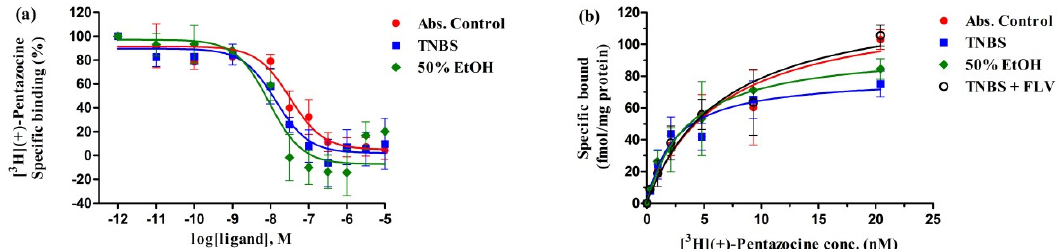
Figure 1. ( a ) Homologous displacement curves for ( + )-pentazocine against [ 3 H]( + )-pentazocine (2.3 nM) binding to sigma-1 receptor ( σ 1R) site in control (Abs. Control) and 2,4,6-trinitrobenzenesulfonic acid-induced colitis (TNBS) or 50% ethanol enema (50% EtOH) treated rat colon membranes. ( b ) Homologous saturation isotherm for [ 3 H]( + )-pentazocine (0.26–20.4 nM) binding to control (Abs. Control) and TNBS-induced colitis rat colon membrane in the absence (TNBS) or presence of 1 mg / kg FLV administration (TNBS + FLV) (described in Section 4.3), 50% ethanol enema (50% EtOH) treated rat colon membranes. Curves are shown as percent specific binding ± S.E.M of at least three independent experiments. Non-specific binding was determined in the presence of 10 µ M haloperidol. Table 1. Binding properties of [ 3 H]( + )-pentazocine for sigma-1 receptor ( σ 1R) in the control and TNBS-induced colitis rat colon tissue in the absence or presence of fluvoxamine (FLV) administration. n.d.: not determined. Values are mean ± S.E.M. of minimum three experiments performed in duplicate. Statistical comparison of the displacement (K i ) and saturation (K d , B max ) binding results was performed by analysis of variance (one-way ANOVA) followed by Bonferroni’s multiple comparison test (* p < 0.05). An asterisk represents a significant di ff erence between inhibitory constants (K i ) of control (Abs. Control) vs. TNBS-induced colitis rat colon membrane (TNBS), and control (Abs. Control) vs. 50% ethanol enema (50% EtOH) treated rat colon membranes. In saturation binding assays asterisk represents a significant di ff erence between maximum binding capacity (B max ) of Abs. Control vs. TNBS-induced colitis rat colon membrane (TNBS); and TNBS-induced colitis rat colon membrane in the absence (TNBS) vs. presence of 1mg / kg fluvoxamine administration (TNBS + FLV). Competition with [ 3 H]( + )-Pentazocine Saturation [ 3 H]( + )-Pentazocine Treatment